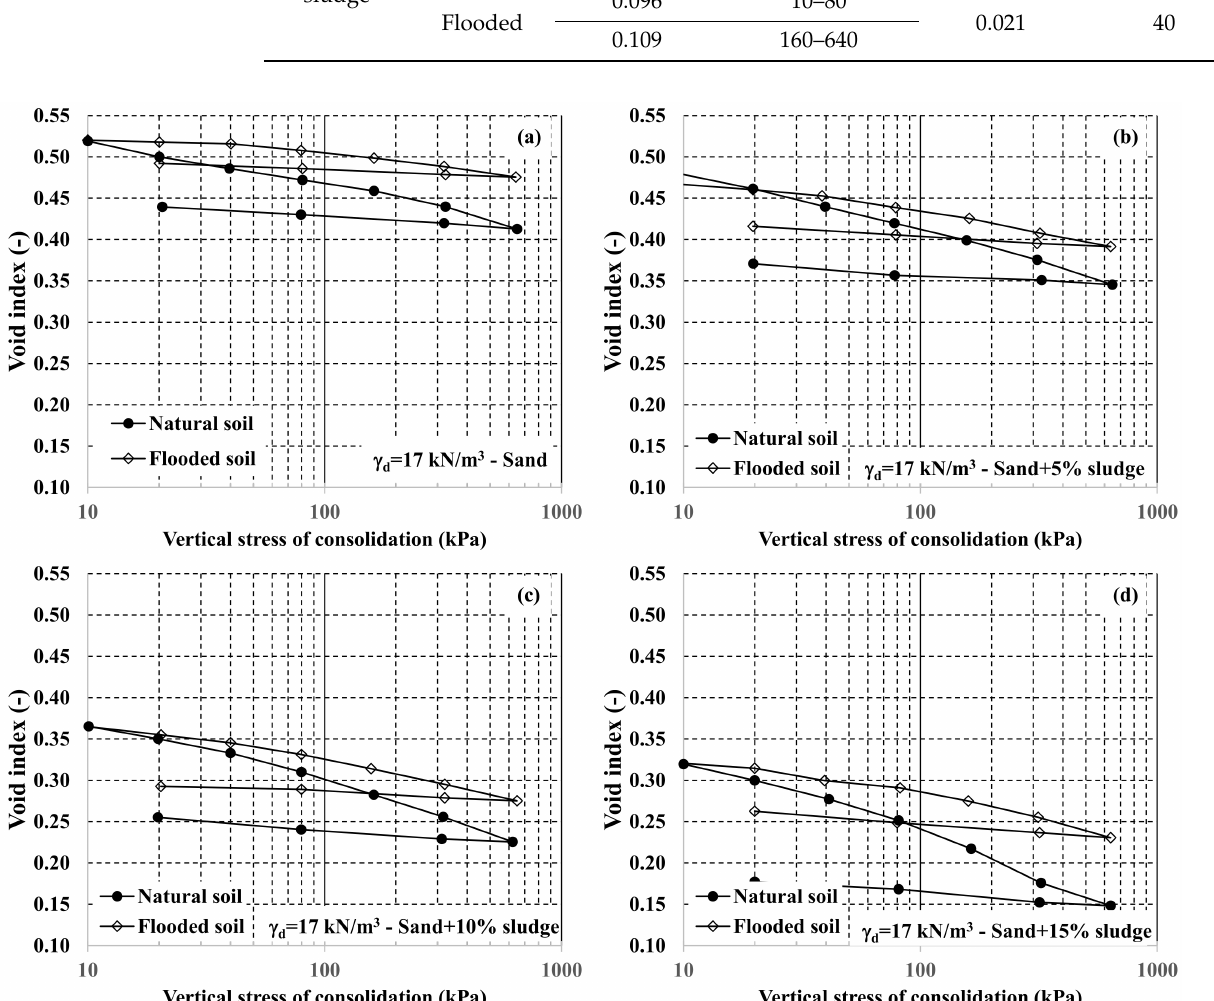
Figure 15. Variation of specific volumetric deformation with the vertical consolidation stress obtained through double oedometer tests, for dry apparent specific weight of 15.0 kN/m 3 : ( a ) sand, ( b ) sand plus 5% sewage sludge, ( c ) sand plus 10% sludge, ( d ) sand plus 15%